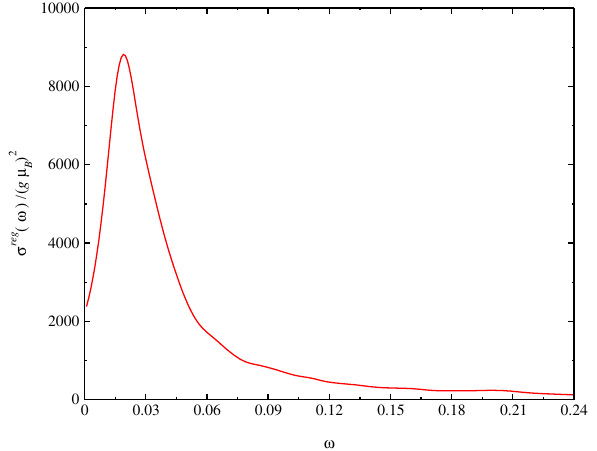
Figure 4. Plot of σ reg (ω) at T for values J 1